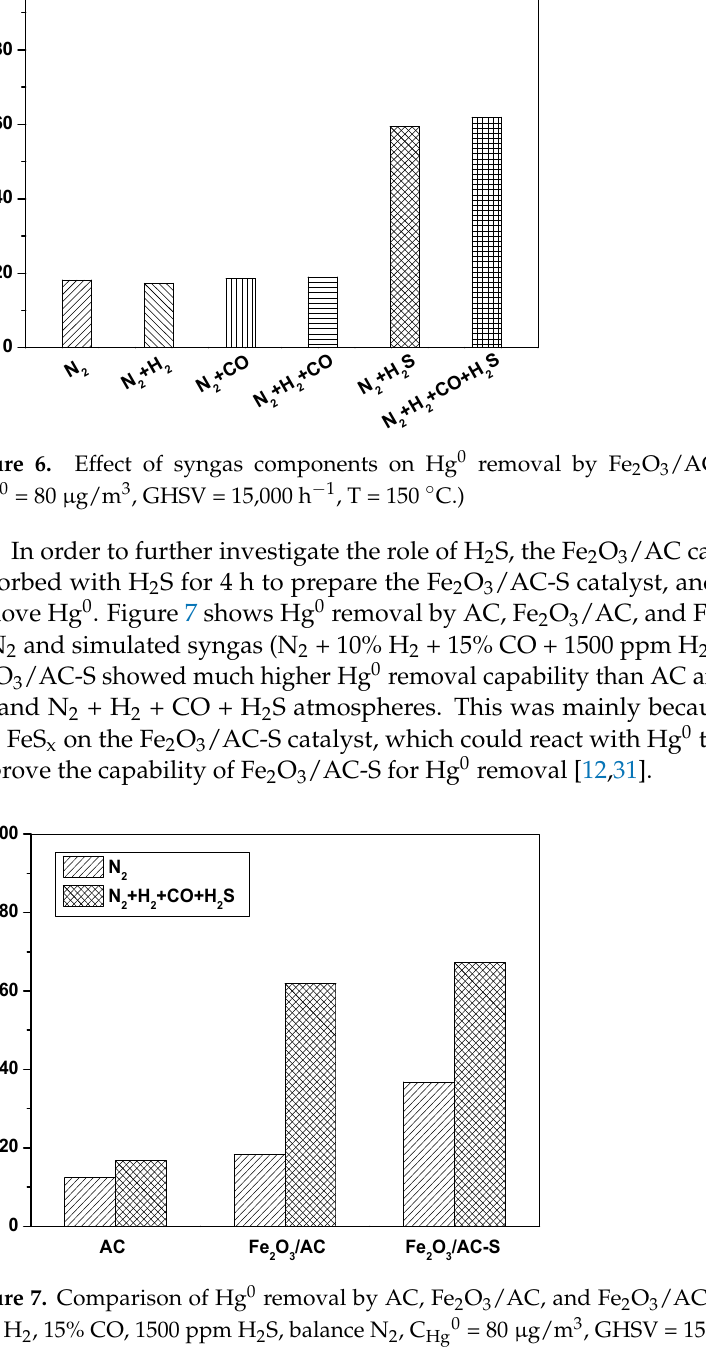
Figure 5. Effect of temperature on Hg 0 and H 2 S removal by Fe10/AC.